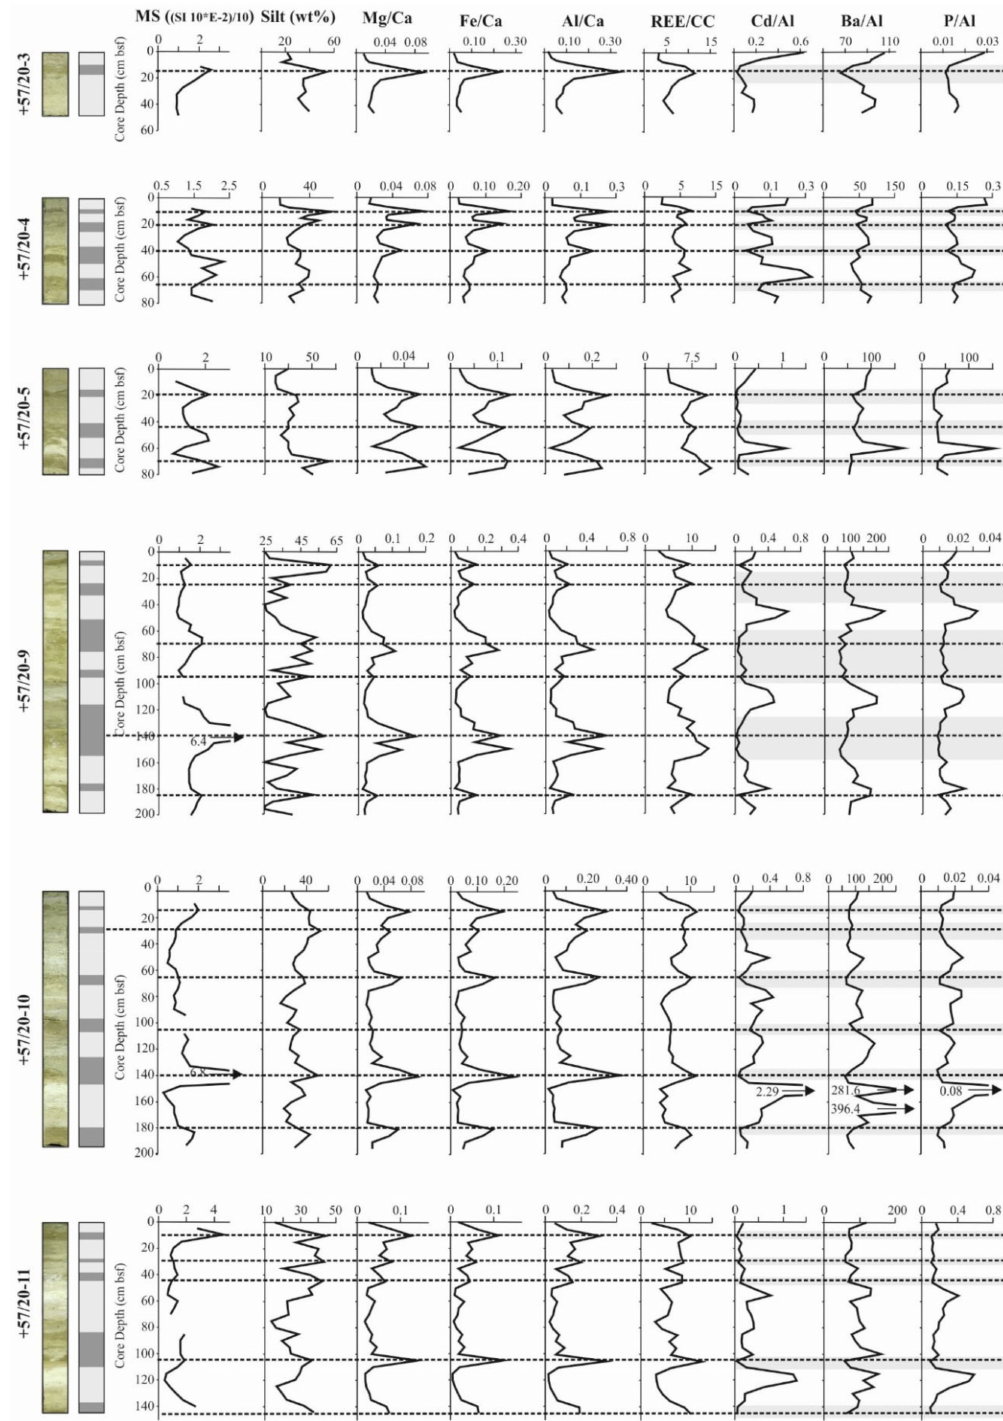
Figure 3. Main results from the gravity cores, as well as the position of prominent peaks (dashed lines) established in this study. From left to right, photograph next to the interpreted sketch based on the two facies described in this study: F1: calcareous ooze (light grey) and F2: lithogenous silt (dark grey). Depth profiles of magnetic susceptibility (MS), silt, Mg / Ca, Fe / Ca, Al / Ca, and REE / CC (Rare Earth Elements normalised by Continental Crust [53]). Depth profiles of palaeoproductivity proxies (Cd / Al, Ba / Al, P / Al) where the grey areas show ratio depletions coincident with the dashed